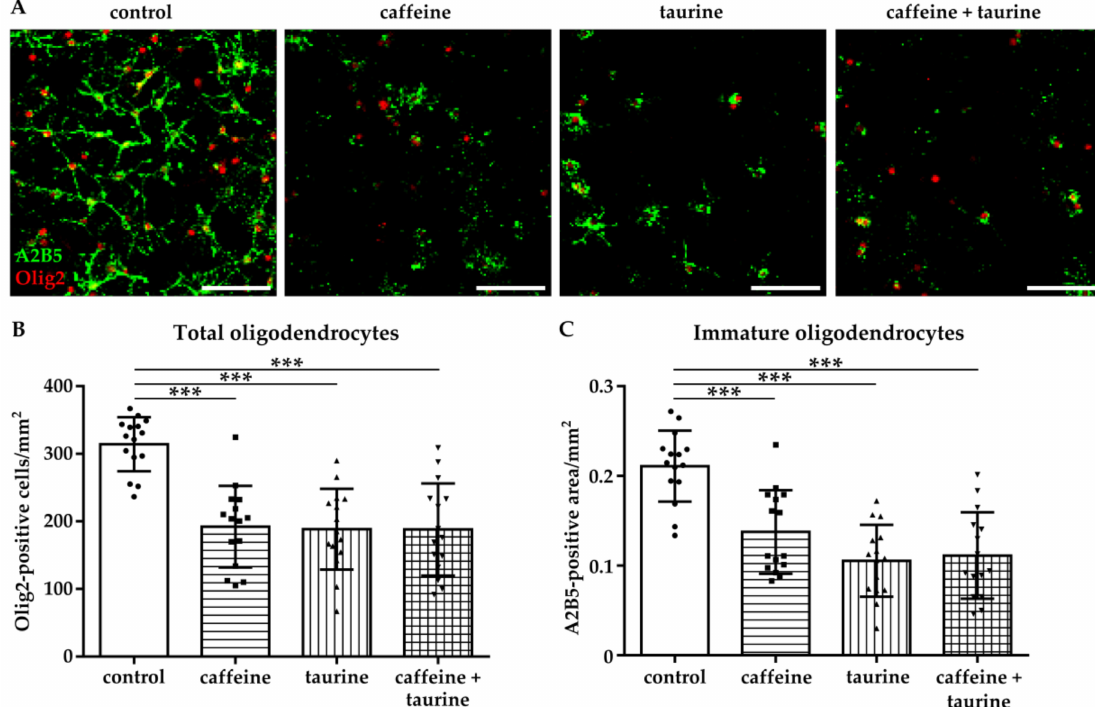
Figure 1. Ca ff eine and taurine alone or in combination induce immature oligodendrocyte cell loss. After three days under standard culture conditions primary immature oligodendrocytes were incubated with or without 0.3 mg / mL ca ff eine, 4 mg / mL taurine, and the combination of both for 24 h. ( A ) Representative images of immunofluorescence staining of immature oligodendrocytes (A2B5 green, Olig2 red). ( B ) Quantification of Olig2 positive cells. The density of immature oligodendrocytes was determined by measuring the A2B5 positive area ( C ). Data are derived from 15 images per group out of three independent experiments (depicted by circle = control, square = ca ff eine, triangle up = taurine, triangle down = ca ff eine + taurine). Scale bar 400 µ m. *** p < 0.001, one-way ANOVA followed by Bonferroni post hoc